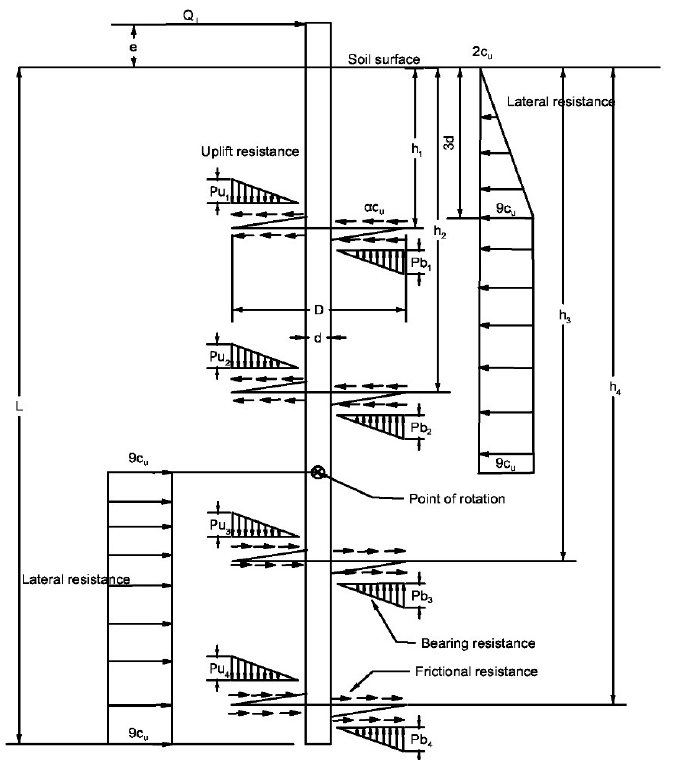
Figure 3. Helical pile at ultimate lateral load [22].